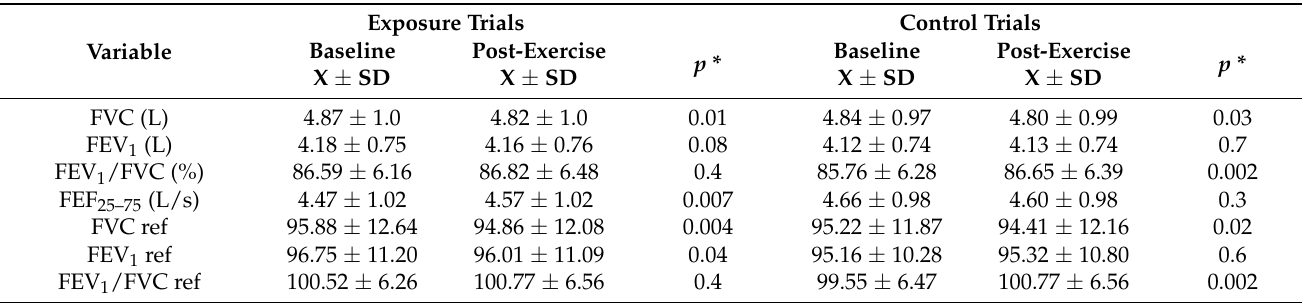
Table 3. Spirometry results noted during exposure and control trials ( n = 71).